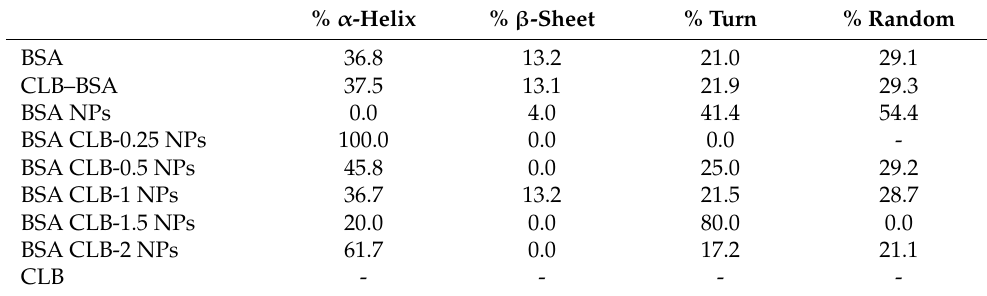
Table 5. The percentage (%) content of BSA secondary structure elements based on Yang’s reference